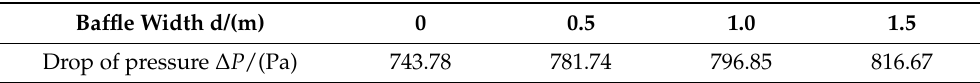
Table 2. Drop of pressure between inlet and